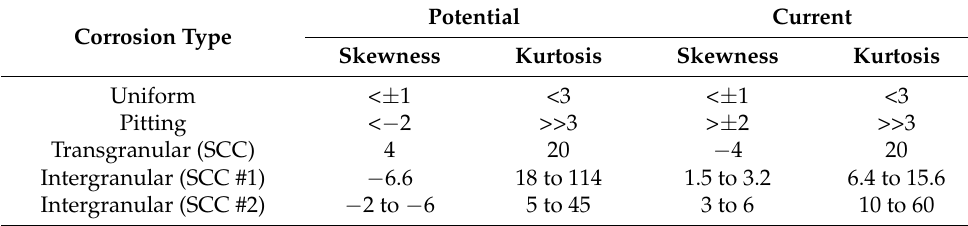
Table 2. Corrosion types evaluated by kurtosis and skewness